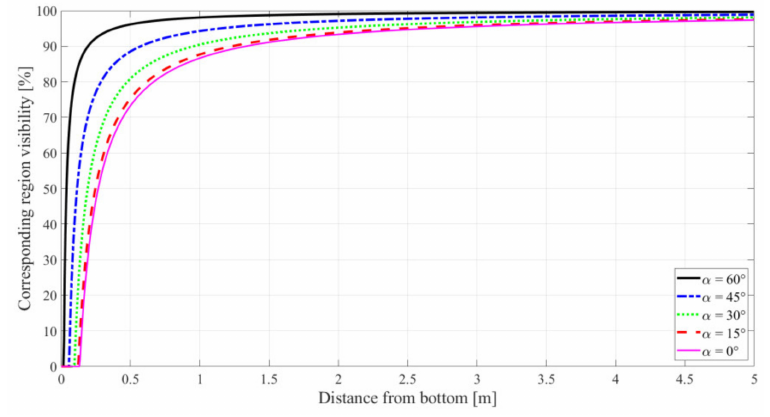
Figure 8. Corresponding region of visibility for different values of α